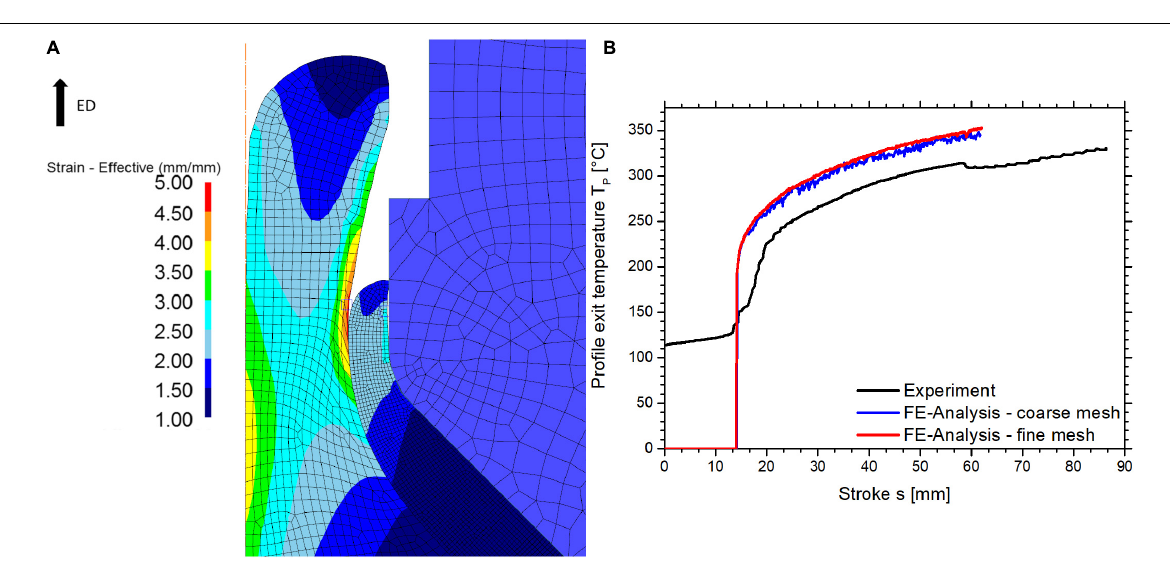
FIGURE 9 | (A) Contour plot of strain in the bearing land during the force peak; (B) extrusion diagram of experiment and FE-analysis: temperature-stroke